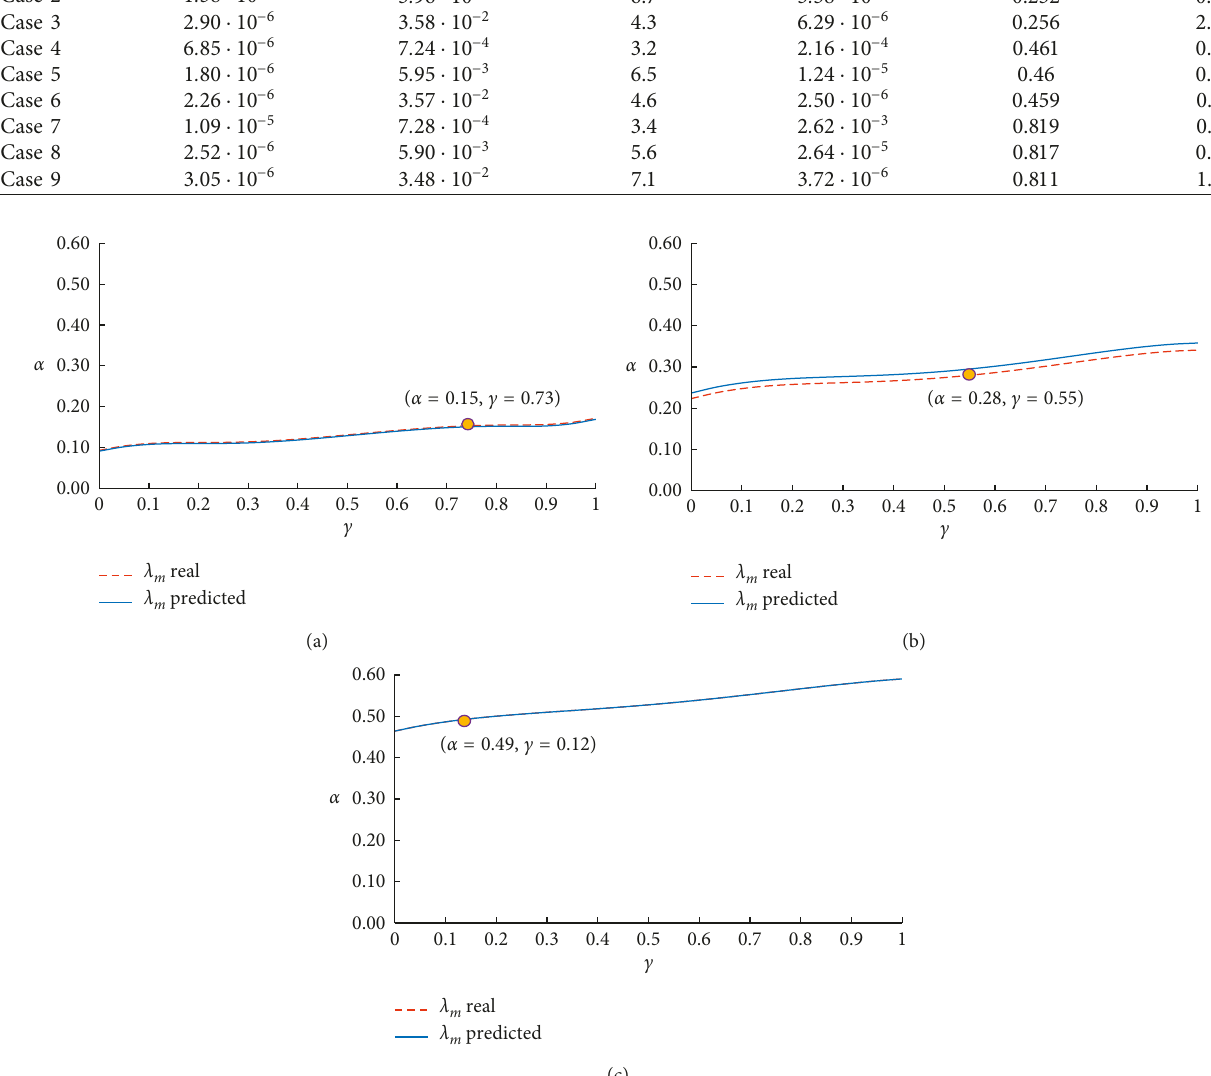
Figure 9: Flexibility curves. Real and predicted values in function of α and c for the studied cases. (a) Cases 1/4/7. (b) Cases 2/5/8. (c) Cases